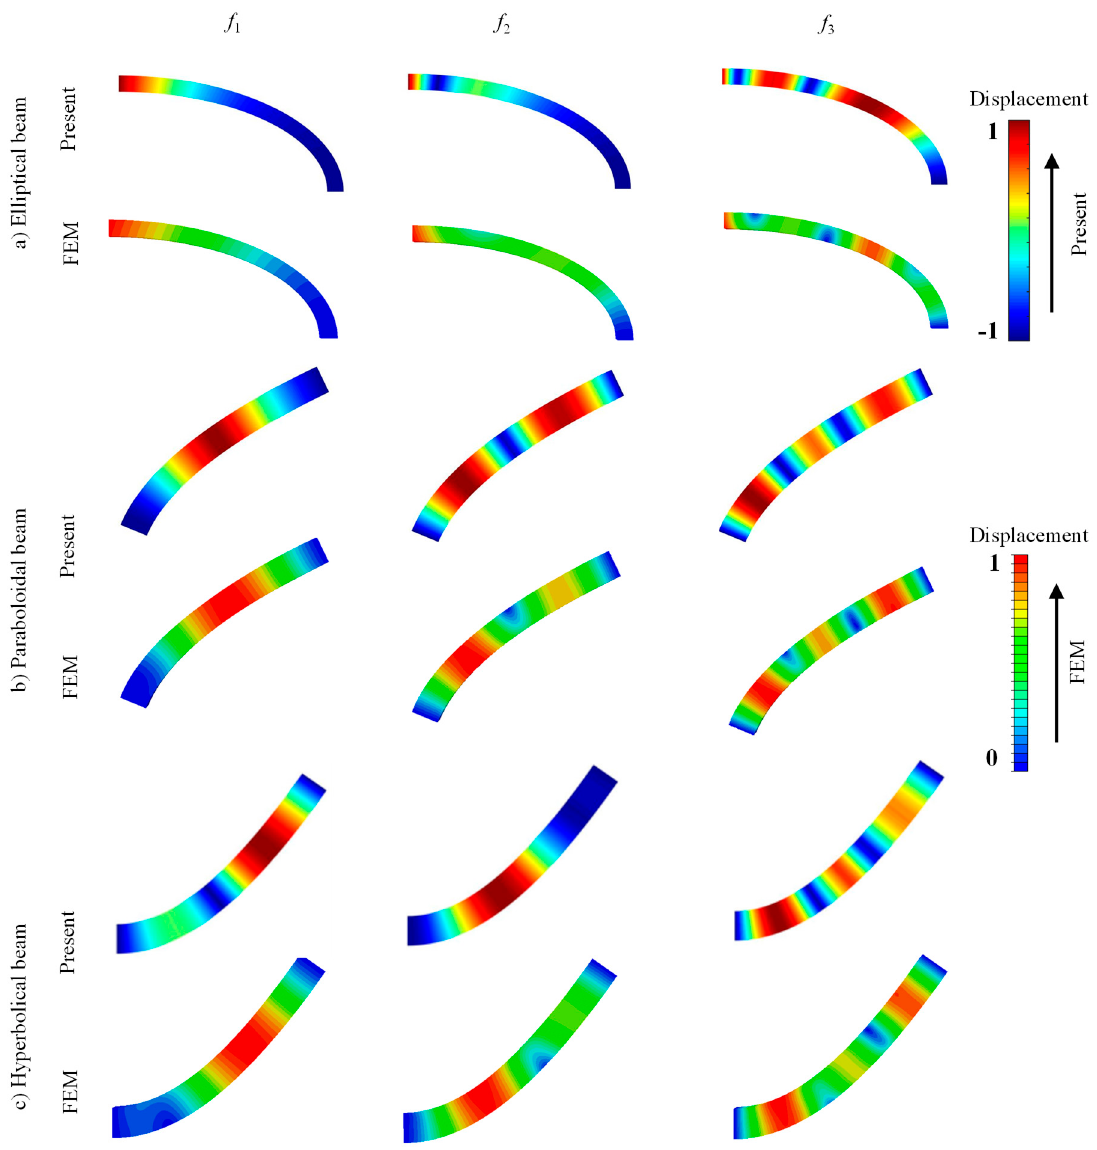
Figure 7. Several mode shapes in x–z plane for CLCBs: ( a ) Elliptical beam, ( b ) paraboloidal beam, and ( c ) hyperbolical beam. Table 3. Comparison of frequencies (first eight modes) for C-C elliptical, paraboloidal, and hyperbolical curved laminated composite beams.